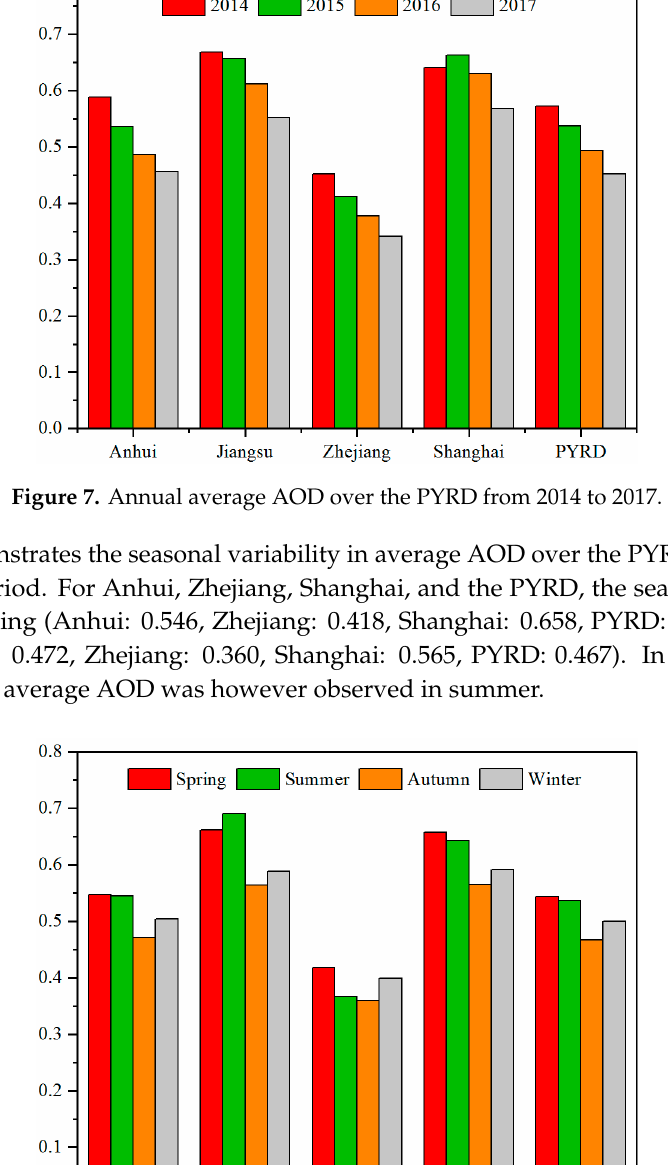
Figure 6 . The spatial distribution of (a) four-year average AOD, (b–e) annual average AOD, and (f–i) seasonal average AOD over the PYRD from 2014–2017.